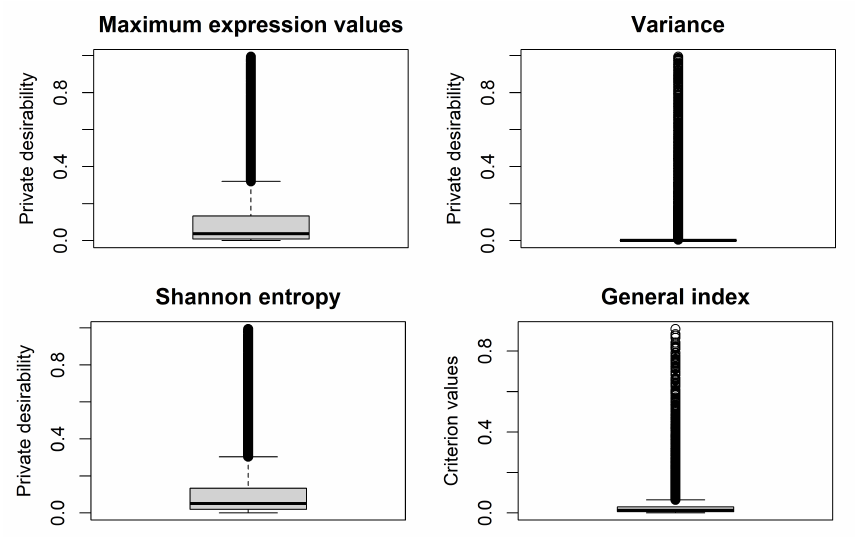
Figure 4. Box plots of private desirabilities and the general desirability index, which determines the gene expression profiles’ significance